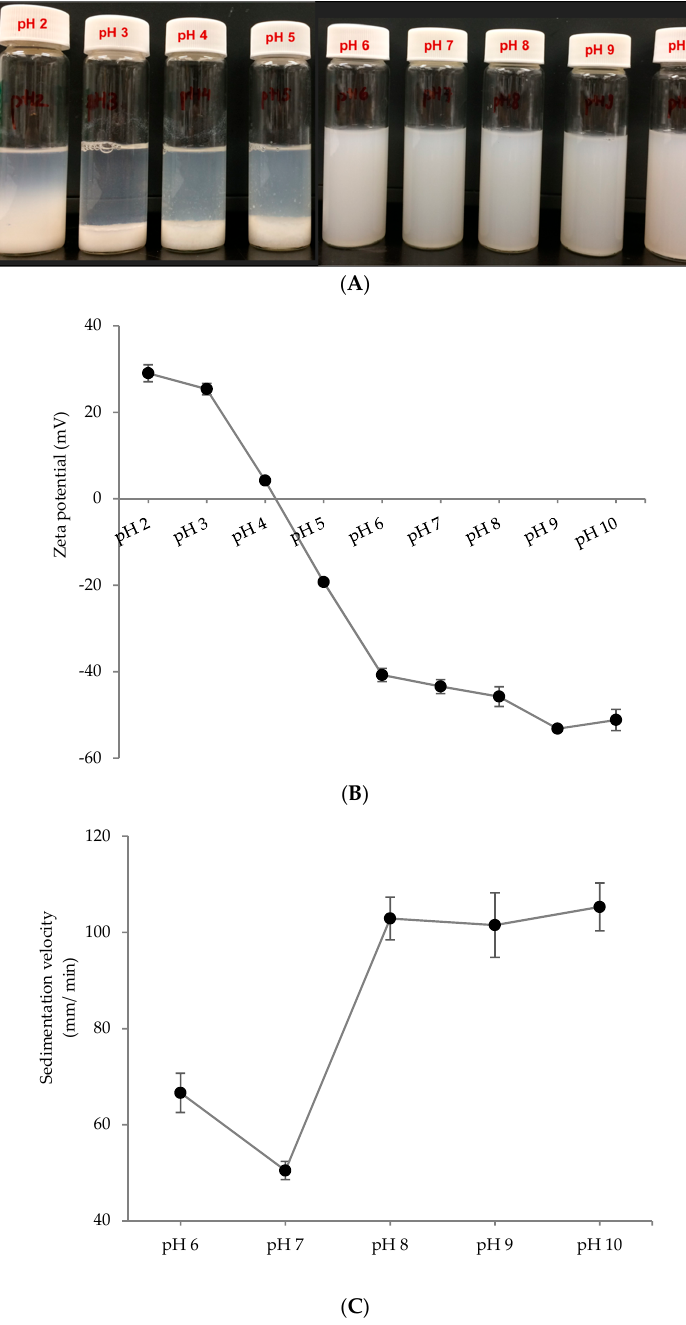
Figure 5. Stability of re-dispersed 2×-desolvated pea protein nanoparticles at different pH values. ( A ) visual observation, ( B ) zeta potential, and ( C ) sedimentation velocity (µm/ min) measured at 1000 rpm (~130 g) in a photocentrifuge.